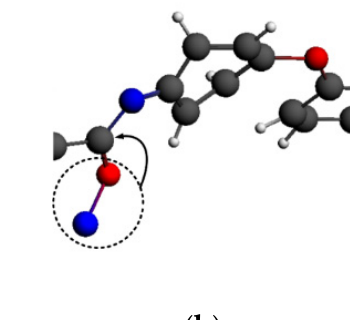
Figure 17. Adsorption process of ∙ NO. ( a ) ∙ NO adsorbed on the PI oxygen atoms; ( b ) ∙ NO adsorbed on the PI carbon atoms.